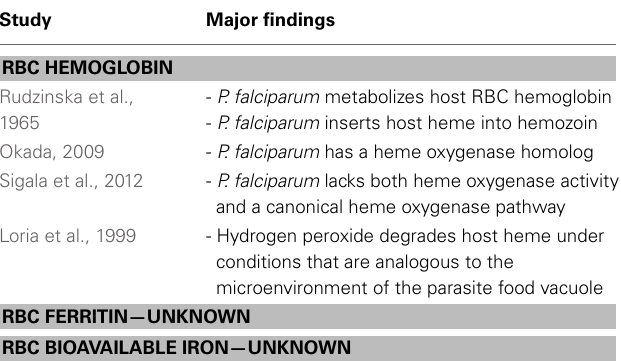
Table 3 | Relationship between RBC iron and P.